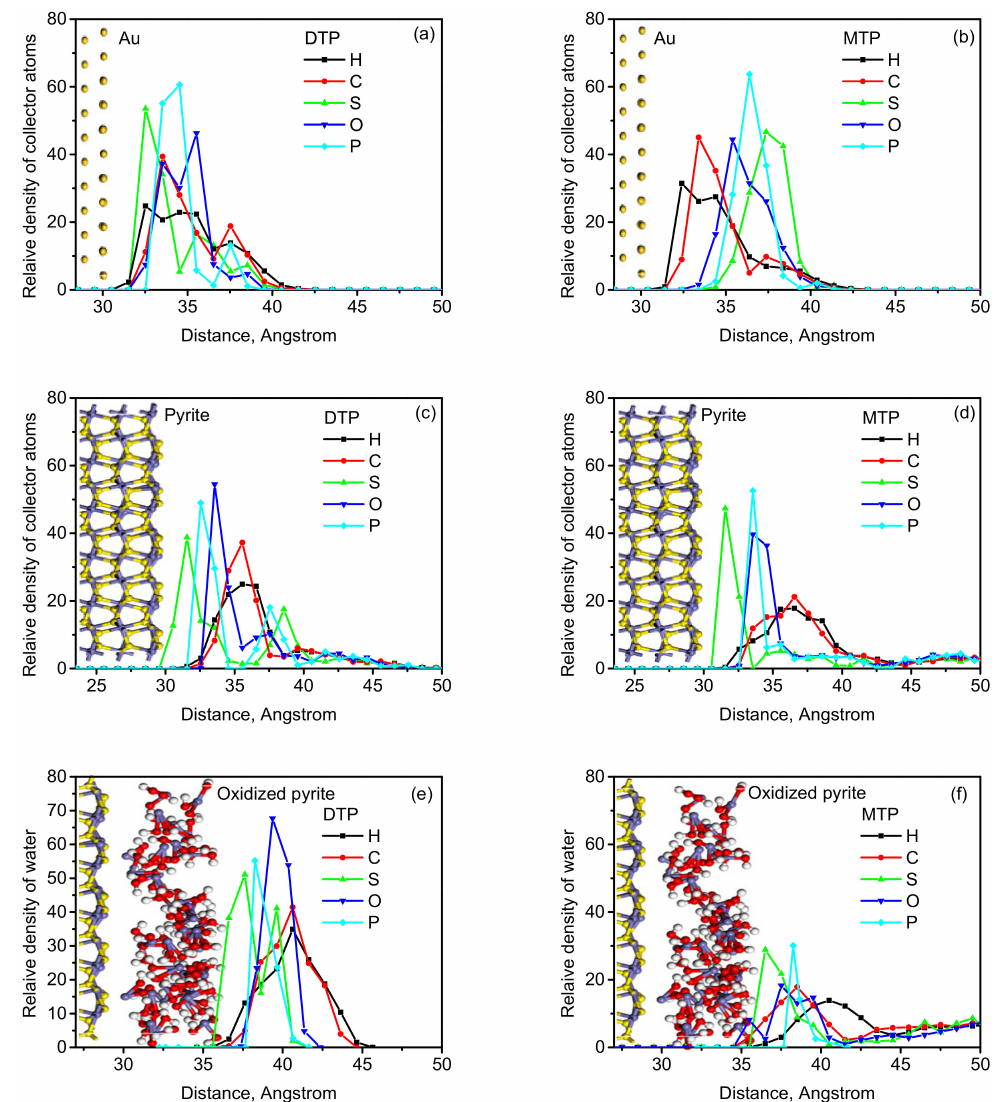
Figure 5. Relative number density distribution of selected atoms from DTP and MTP along the normal to the Au (111) surface ( a , b ), pyrite (100) surface ( c , d ), and oxidized pyrite (100) surface ( e , f ). Fe(OH) 3 : dark grey: iron; white: hydrogen; red: oxygen. Pyrite: yellow: sulfur; purple: iron. Gold: dark yellow: